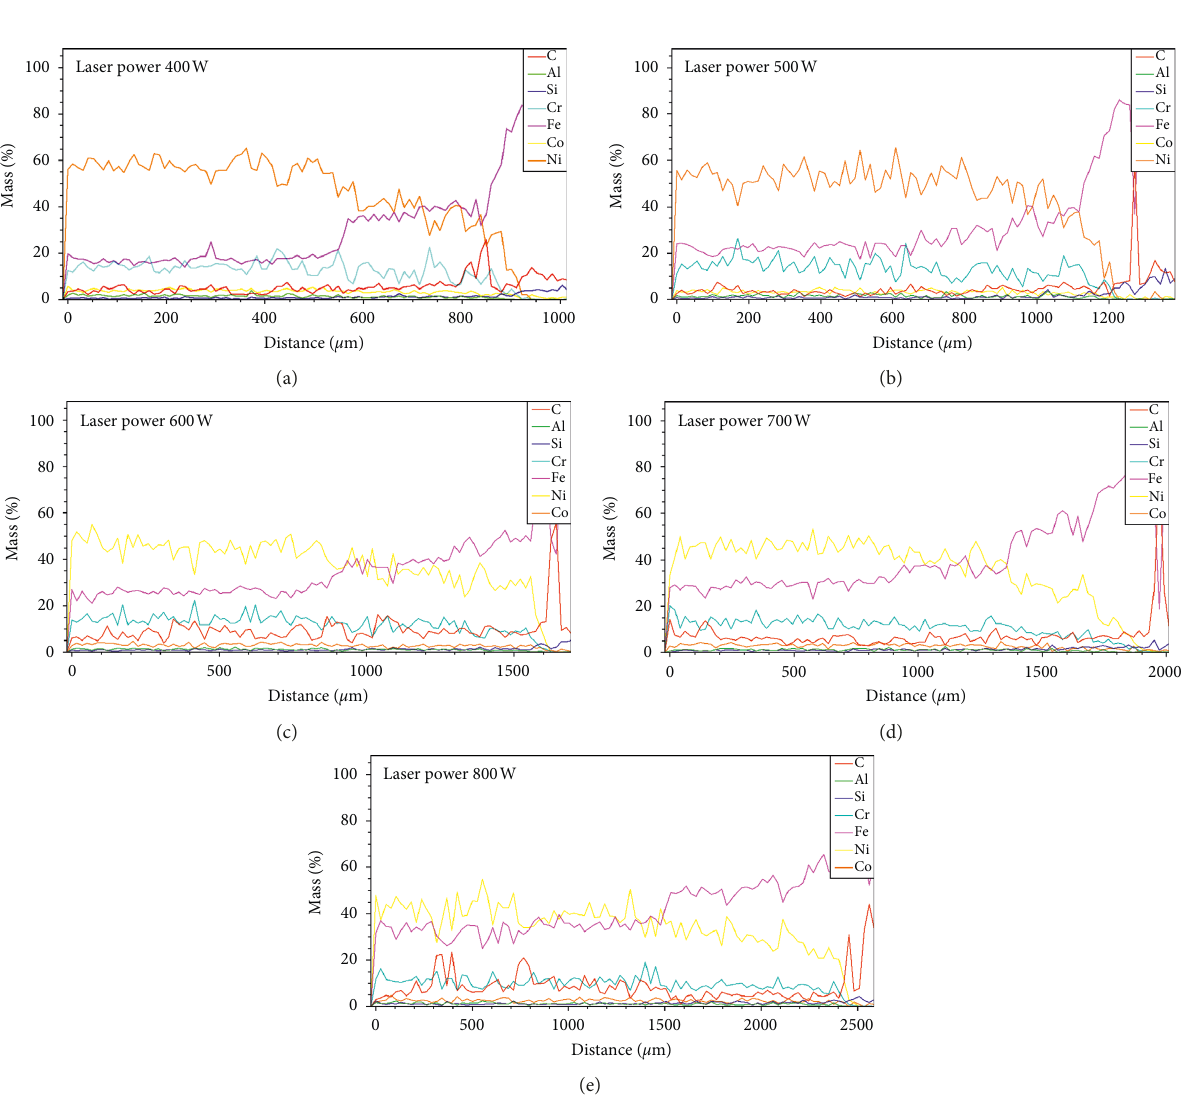
Figure 10: EDS line scanning analysis from coating to substrate: (a) 400W,(b) 500W, (c) 600W, (d) 700W, and (e)